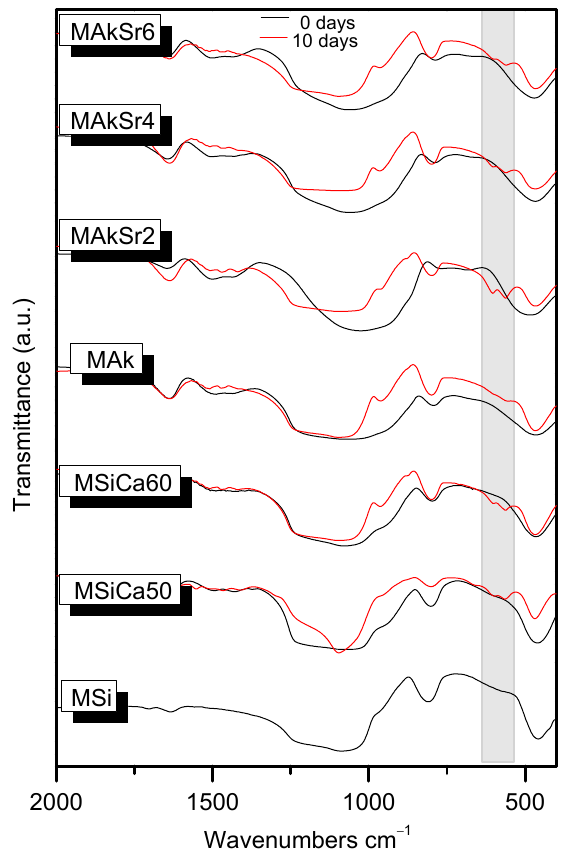
Figure 1. FTIR spectra of all mesoporous silica-based nanoparticles (MSNs) before (0 days) and after 10 days of immersion in simulated body fluid (SBF).